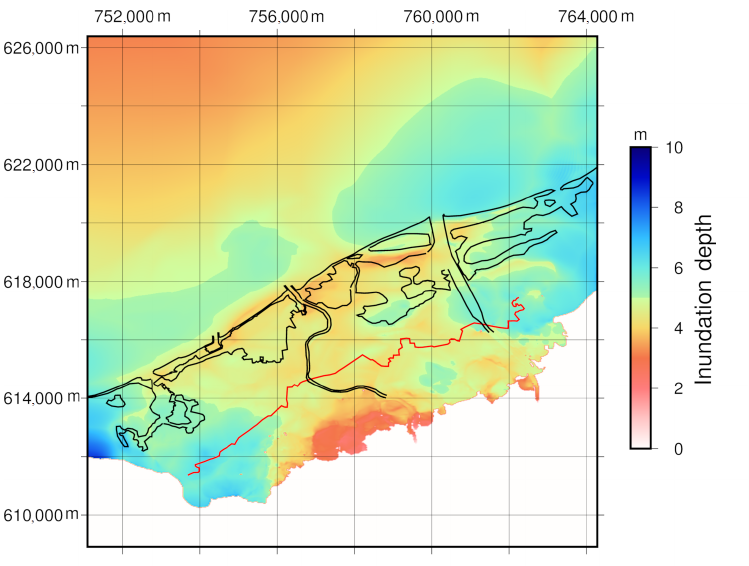
Figure 6. Map of the maximum inundation depth (m). The red line indicates the inundation limit based on the real event. The black line marks the Banda Aceh shoreline before the tsunami.